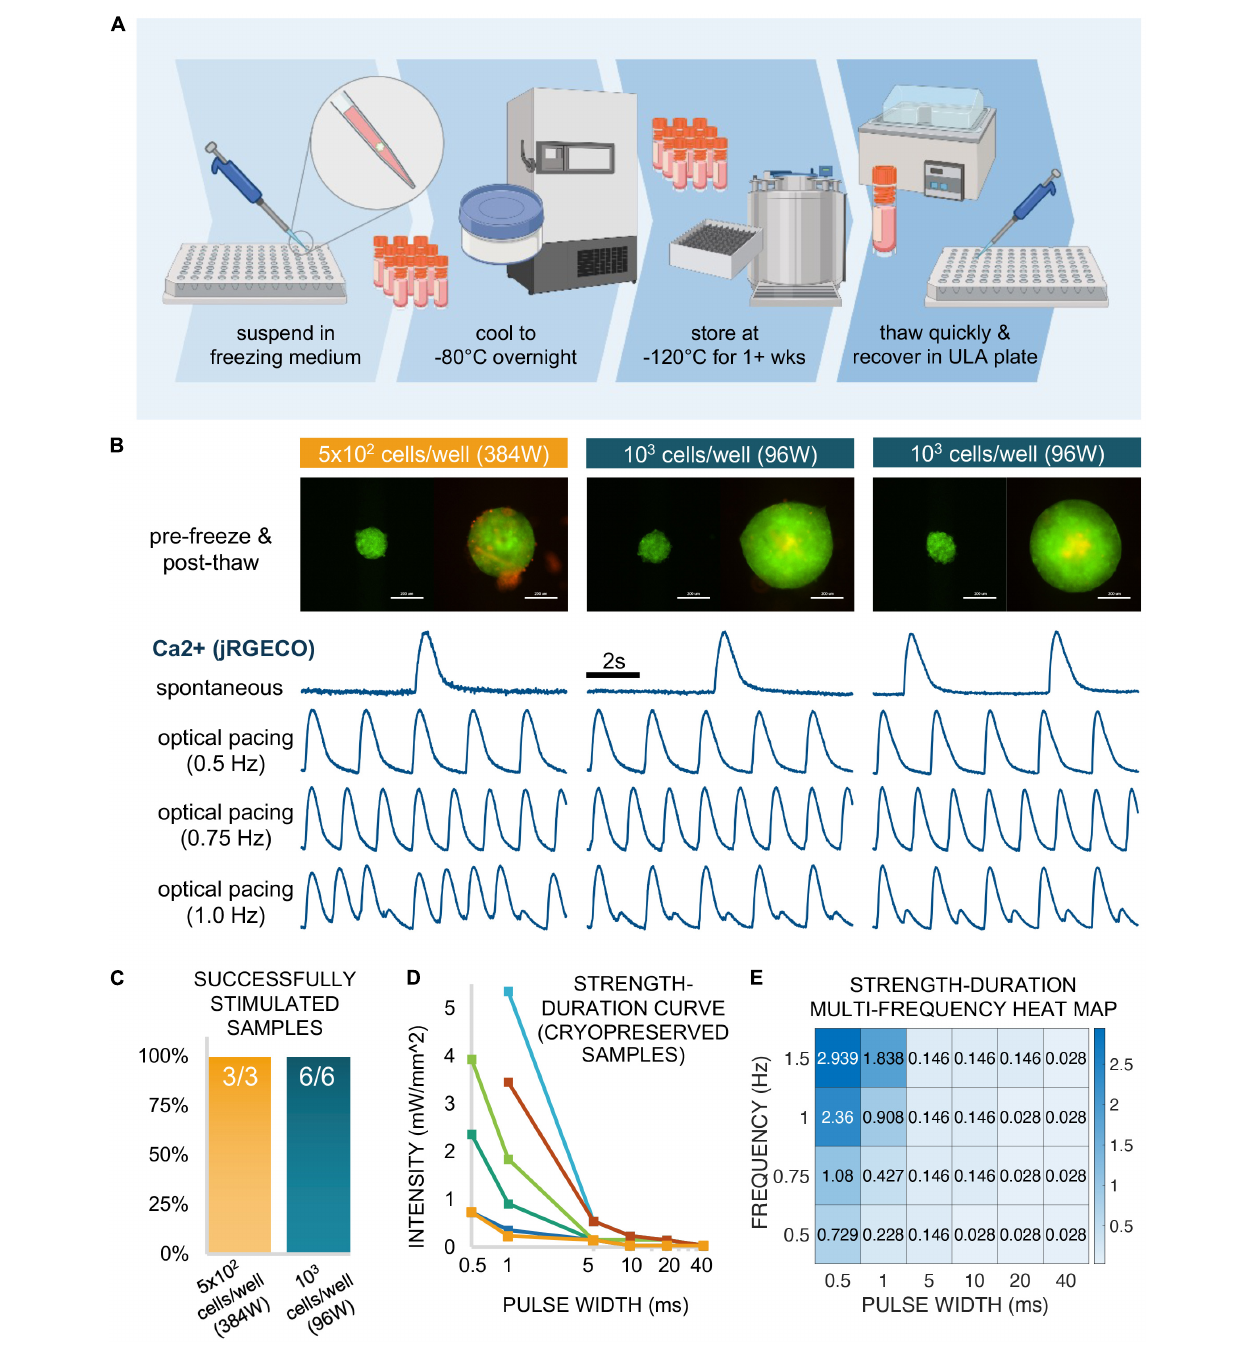
FIGURE 8 | Functional responses via cryopreserved spark-cell clusters. (A) Schematic representation of the spheroid cryopreservation process, both freezing and thawing. (B) Sample spheroids (1 sample seeded in a 384-well spheroid plate at 5 × 10 2 cells/well and 2 samples seeded in a 96-well spheroid plate at 10 3 cells/well) from which functional data was obtained. Images (ChR2-eYFP and PI) represent spheroids 1 day before freezing and 6 days after thawing (or 1 day before functional measurements were performed). Scale bar is 0.2 mm. For each depicted spheroid are the corresponding calcium traces from jRGECO-expressing iPSC-CMs show spontaneous activity and responses to optical pacing by a spheroid at three frequencies 18 h after spheroids were applied. Stimulation at 0.5 and 0.75 Hz resulted in a 1:1 response ratio while varying patterns alternans were observed for these samples at 1.0 Hz. (C) Of the thawed spheroids that were introduced to iPSC-CMs, all (100%) of the samples demonstrated optical pacing. (D) A strength-duration (blue light intensity, pulse width) curve was constructed for 6/9 of the responsive cryopreserved samples at six discrete pulse widths: 40, 20, 10, 5, 1, and 0.5 ms. (E) For one of these six samples, a strength-duration heat map was constructed at multiple frequencies (0.5, 0.75, 1.0, and 1.5 Hz) where blue light intensity threshold (mW/mm 2 ) for stimulation increases as pulse width decreases and/or frequency increases. Panel (A) was created using